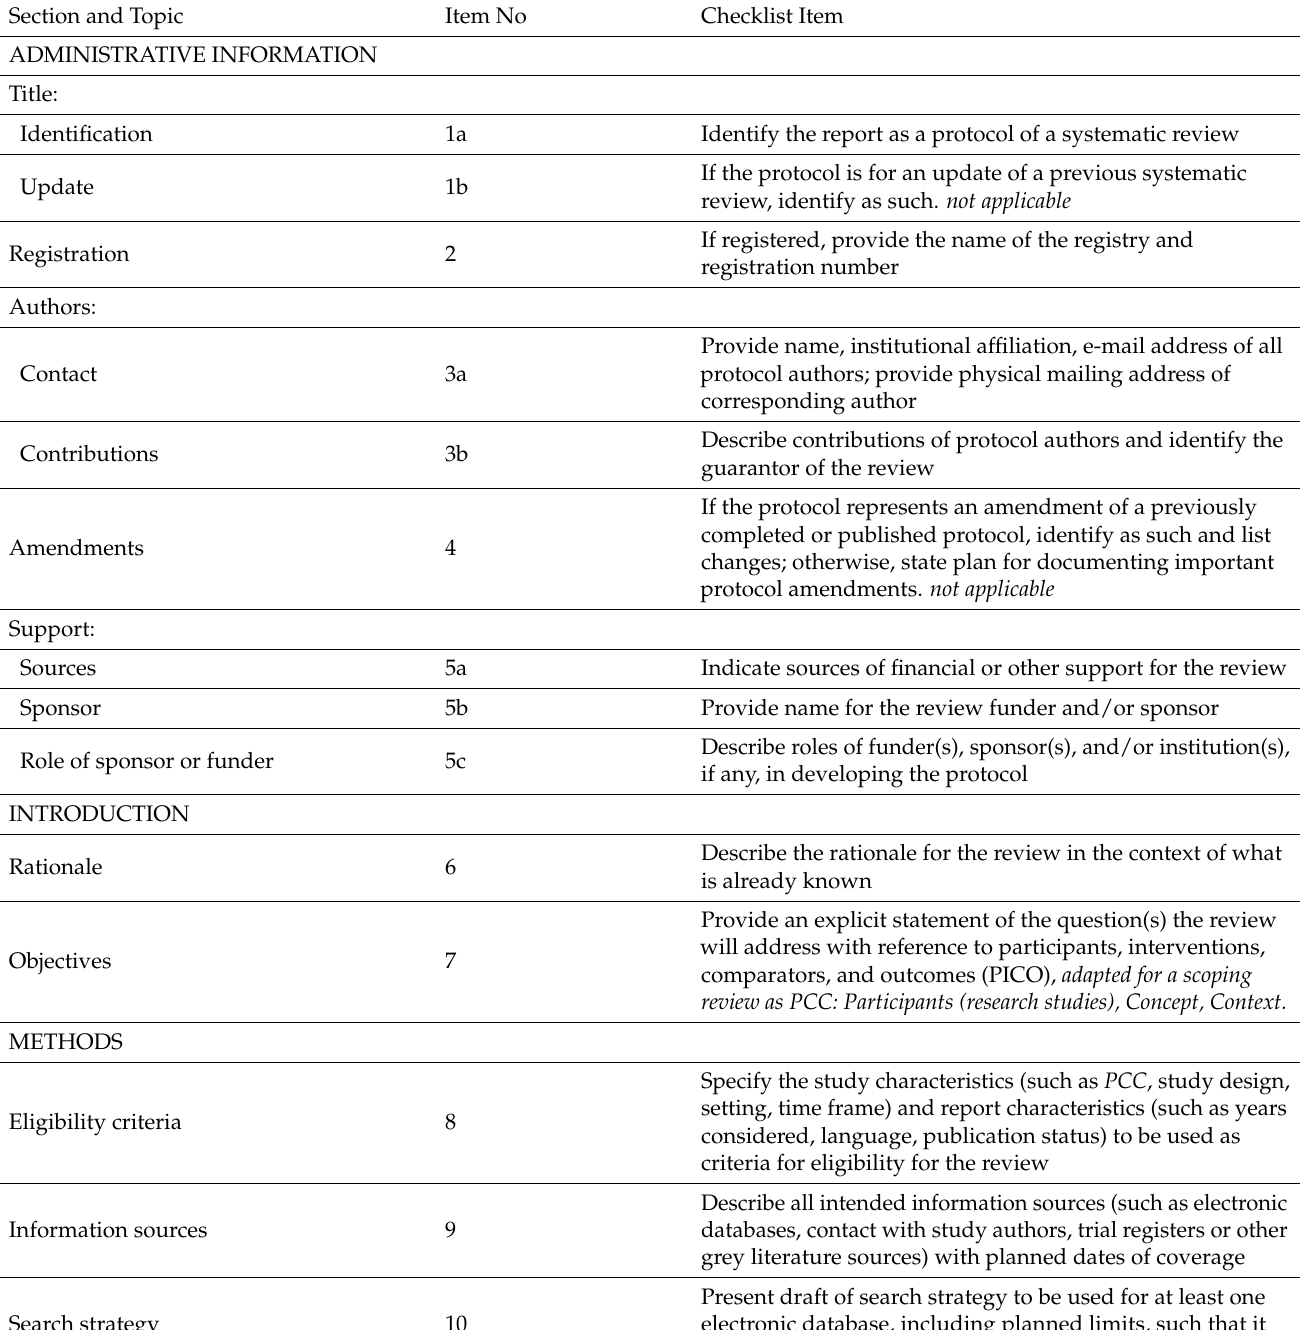
Table A1. PRISMA-P (Preferred Reporting Items for Systematic review and Meta-Analysis Protocols) 2015 checklist: recommended items to address in a systematic review protocol—adapted for a scoping